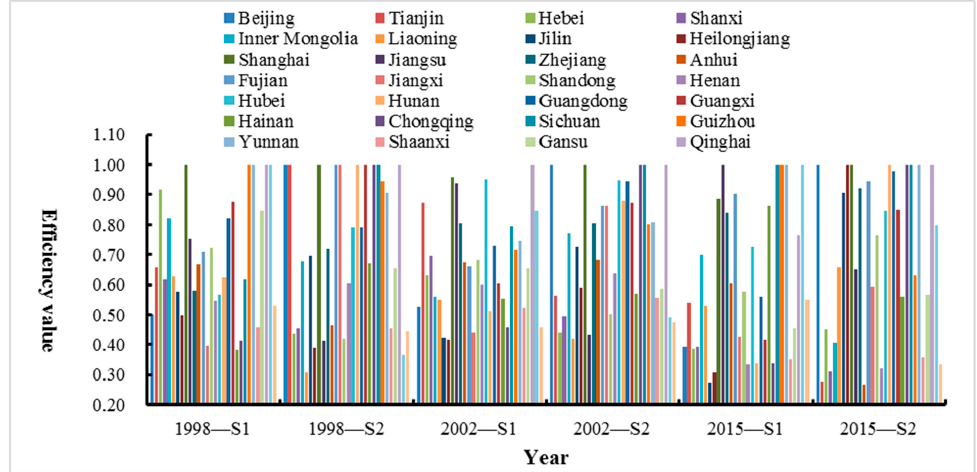
Figure 4. The environmental efficiency level of the power industry in China’s 30 provinces under different power reforms. Table 3. The environmental efficiency level by link of the power industry in China’s 30 provinces of 1998–2019. Province